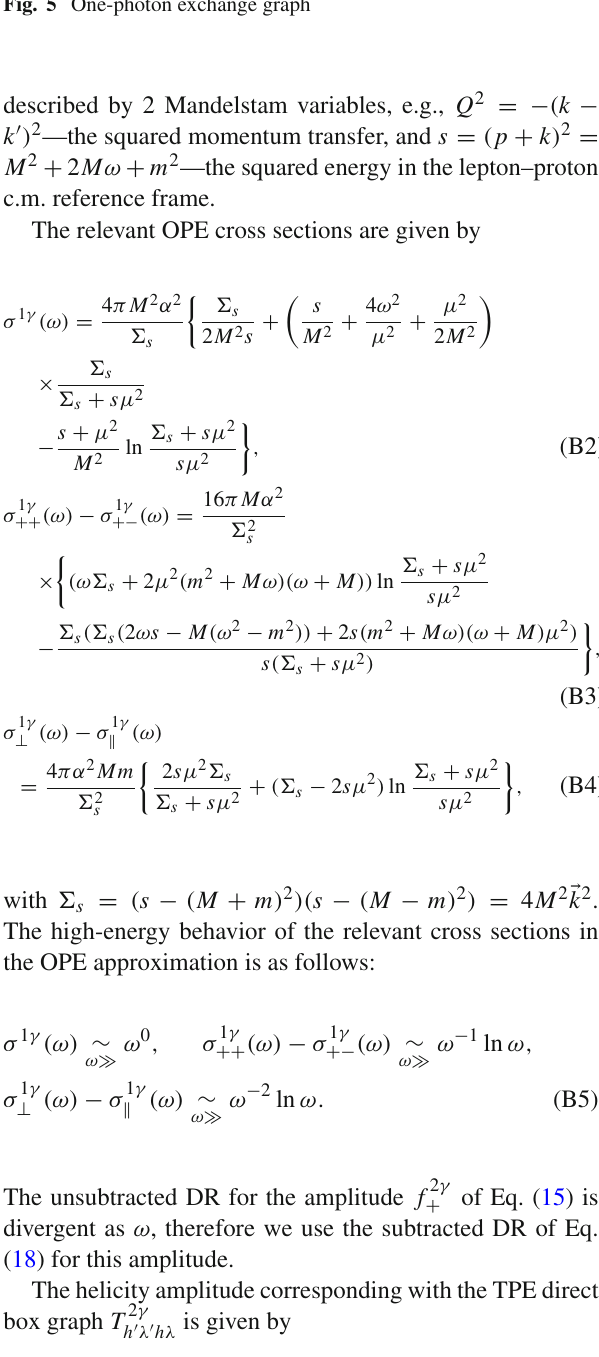
Fig. 5 One-photon exchange graph